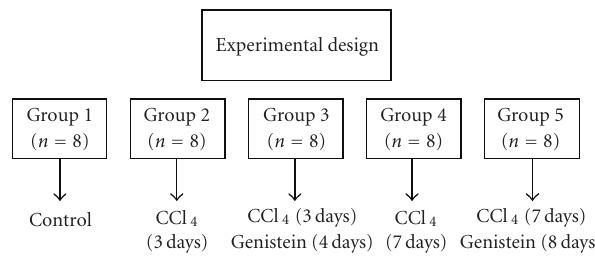
Figure 1: Schematic design of